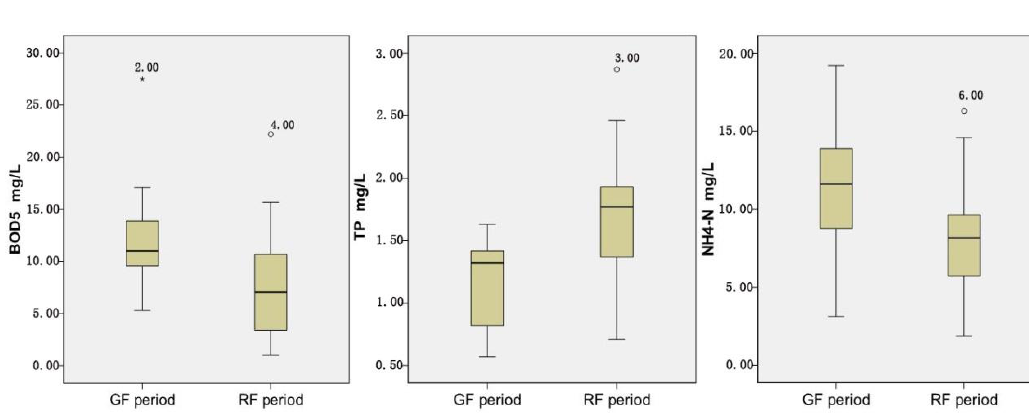
Figure 3. The trend of temporal variations of significant water quality parameters in TSBR.